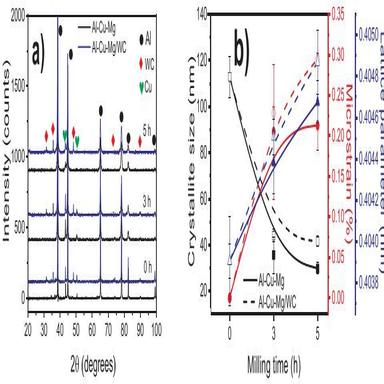
a) X-ray diffraction patterns, b) crystallite sizes, lattice parameters, and microstrains of the matrixes of Al-Cu-Mg/WC composite powders prepared with various milling times.